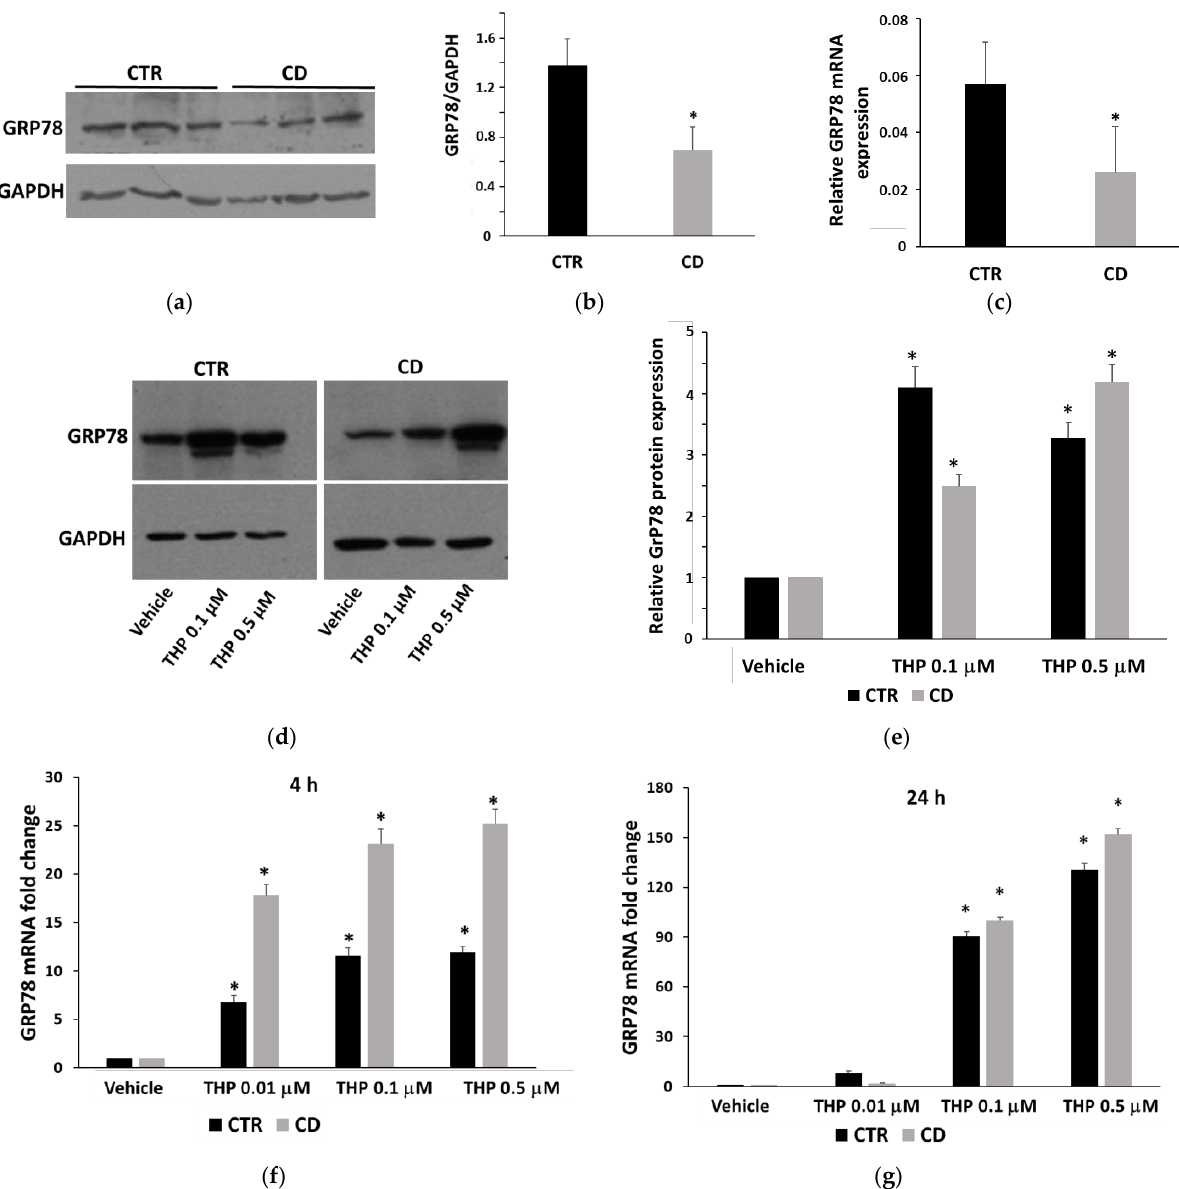
Figure 3. GRP78 expression. ( a ) Representative Western blot of the basal level of GRP78 in samples from three control and three celiac cultures. ( b ) Densitometric analyses of GRP78 basal levels, nor- malized with respect to GAPDH expression, relative to five controls and five celiac cultures. ( c ) Relative basal GRP78 mRNA levels measured in cultures from three control and three CD subjects. In panels ( a – c ), data are reported as mean ± SE. * p < 0.05 vs. controls (Student’s t -test for unpaired data). ( d ) Representative Western blot anti-GRP78 on samples from one control and one celiac cul- ture in the presence of THP for 24 h. ( e ) Densitometric analyses relative to Western blot anti-GRP78 on samples from three control and three celiac cultures in the presence of THP. ( f , g ) Relative GRP78 mRNA levels measured in samples from three control and three celiac cultures in the presence of THP for 4 h and for 24 h, respectively. In ( e – g ) protein and mRNA levels are normalized with respect to GAPDH expression and expressed as variation with respect to the relative vehicle-treated sample. Data are reported as mean ± SE. * p < 0.05 vs. the respective vehicle. ( a ) ( b ) Figure 4. Detection of XBP1 splicing after treatments of control and CD cells with THP for 4 h. ( a ) Spliced (s) and unspliced (us) forms of XBP1 in representative samples are detected in a 2.5% aga- rose gel after staining with ethidium bromide. ( b ) Quantification of XBP1 splicing in cultures from three control and three CD subjects expressed as a ratio between densitometric values of s-XBP1 and us-XBP1. Data are reported as mean ± SE. * p < 0.05 vs. the respective vehicle. ** p < 0.05 as indicated (Student’s t- test for unpaired data). 2.4. Differences in THP-Induced Autophagy in Control and CD Fibroblasts Since ER stress is a potent trigger of autophagy, we investigated whether THP treat- ments produced differential autophagic responses in CD and non-CD fibroblasts. Changes in the level of the two forms of LC3, LC3-I, and LC3-II, were monitored. We first observed that the ratio between basal LC3-II and LC3-I was generally higher in CD cells than in control ones (Figure 5a,b). Moreover, confocal images of basal LC3 showed a more marked presence of large perinuclear vesicles in CD samples than in control ones (Figure